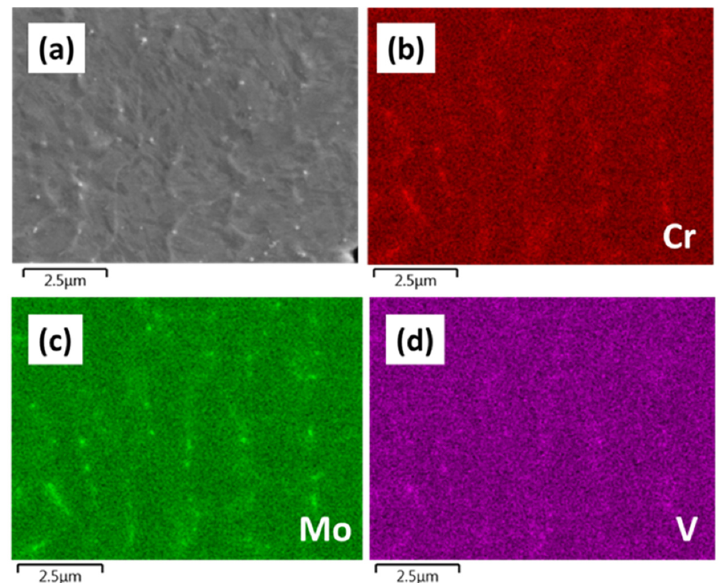
Figure 5. The standard 1.2343 as-built ( a ) showing the cell boundaries with carbides. ( b – d ) EDS map showing the micro segregations of Mo, Cr, and V on the cell boundaries and carbides. The presence of the concentration gradients of the micro segregation is best seen in Figure 5c (Mo).